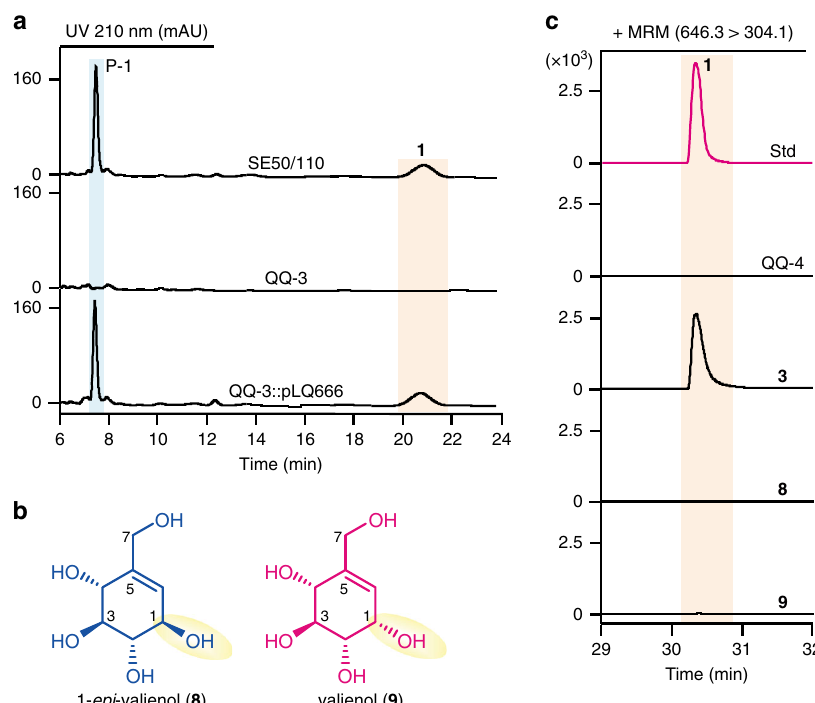
Fig. 2 Discovery and identi fi cation of shunt products accumulated in the fermentation broth of Actinoplanes sp. SE50/110. a HPLC pro fi les of the parent strain Actinoplanes sp. SE50/110 (abbreviated as SE50/110), the Δ acb mutant QQ-3 and the complemented mutant QQ-3::pLQ666. b Structures of 1- epi - valienol ( 8 ) and valienol ( 9 ). c HPLC-QQQ/MS analysis of 1 after feeding with 3 (as positive control), 8 or 9 to the Δ acbC mutant QQ-4, and fermentation of QQ-4 without feeding was set as negative control. The standard (abbreviated as std) of 1 was also analyzed. Source data underlying Fig. 2c are provided as a Source Data fi